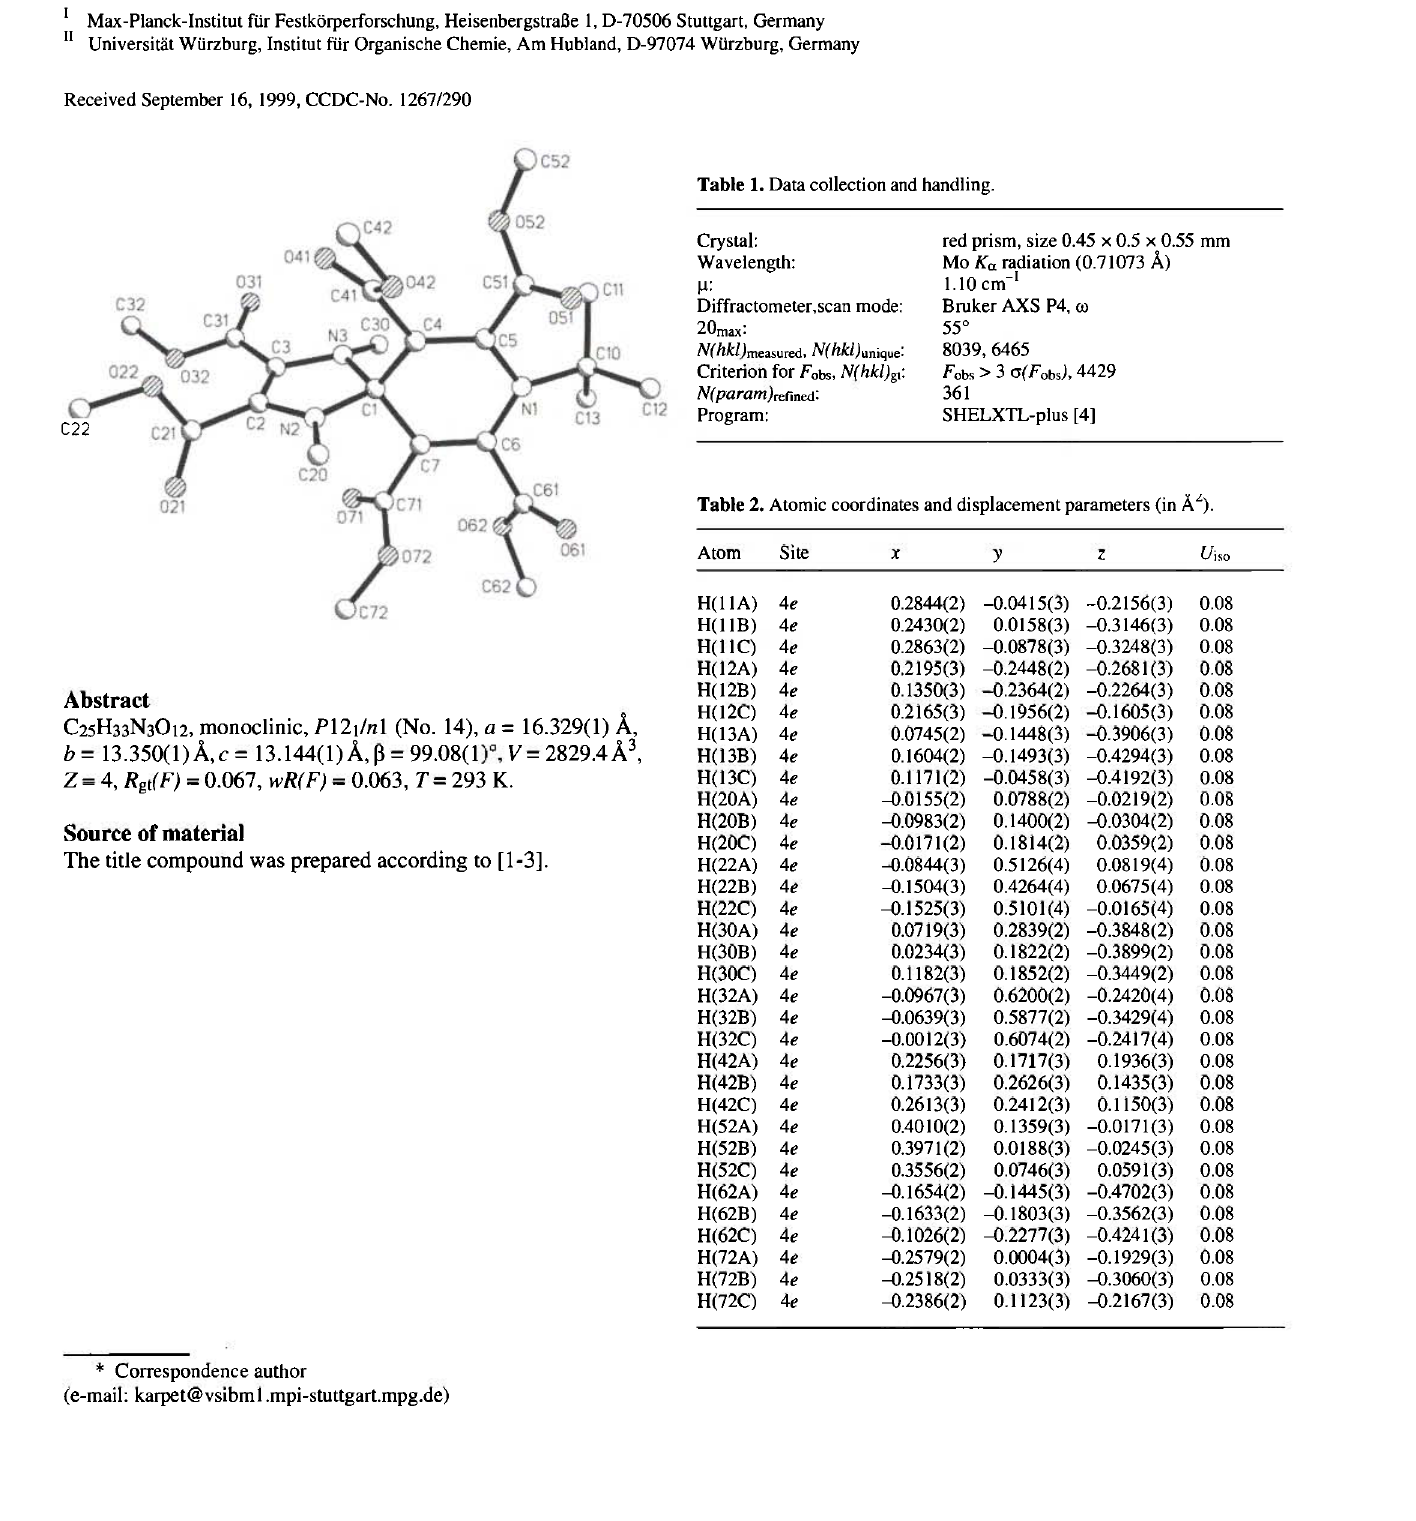
Table 1. Data collection and handling.